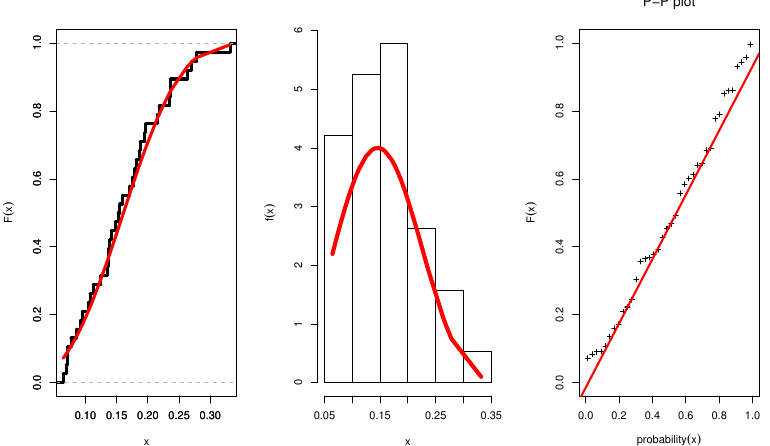
Figure 18. Estimated pdf, CDF and P-P plots of UEPD for France COVID-19